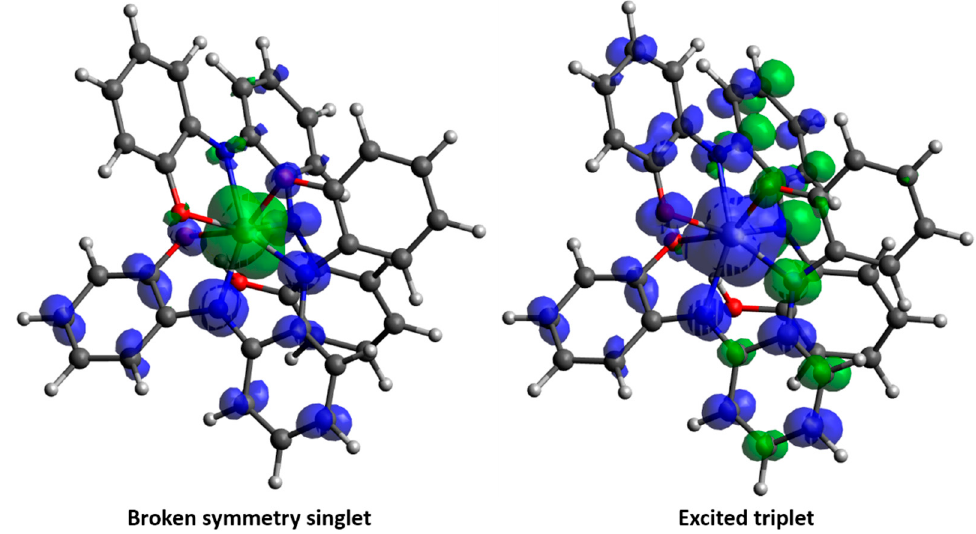
Figure 3. Spin density plots for broken symmetry singlet and excited triplet states of modified structure of [V(L)(HL)].